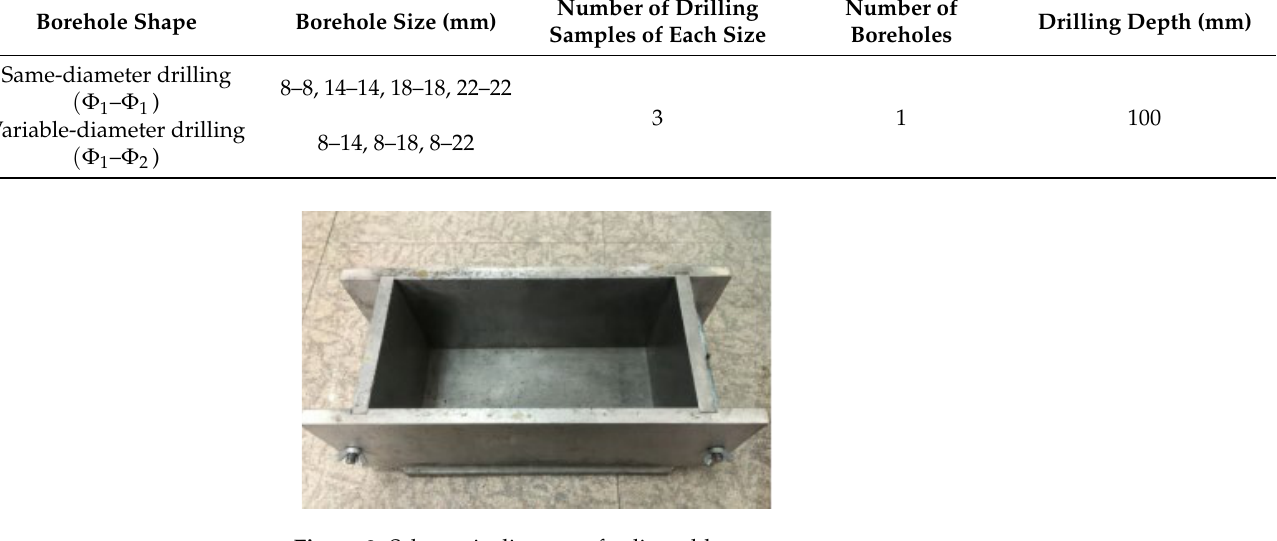
Figure 2. Schematic diagram of split mold.